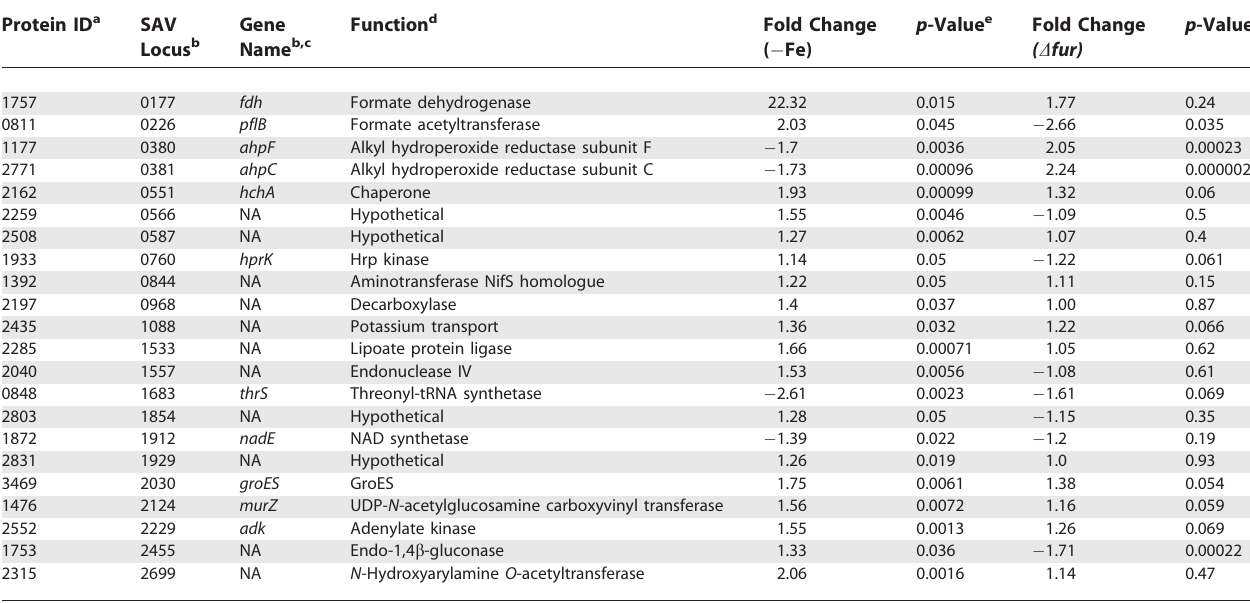
Table 4. Proteins Affected by Iron Independently of Fur Protein ID a